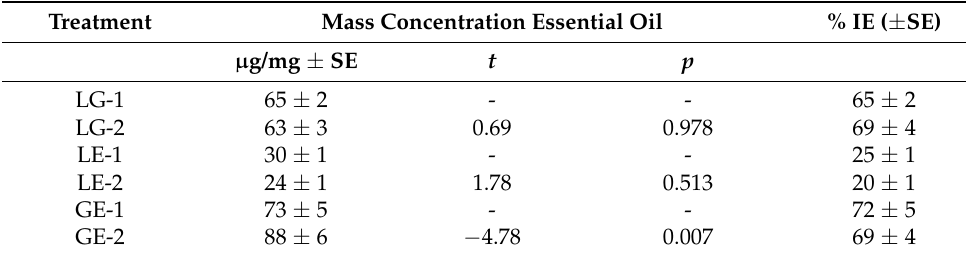
Table 2. Mass ( µ g) of essential oil per mg of inclusion complex, and % inclusion efficiency (% IE) of essential oil in the inclusion complexes. Essential oils contained in the inclusion complexes were extracted in triplicate, diluted with internal standard solution in hexanes, and analyzed by GC-FID. Quantification of essential oil was done using 400–10 ng/ µ L standard curves containing 40 ng/ µ L internal standard in hexanes. Values were calculated from averaging measurements from three extracts and are presented along with their standard error (SE).